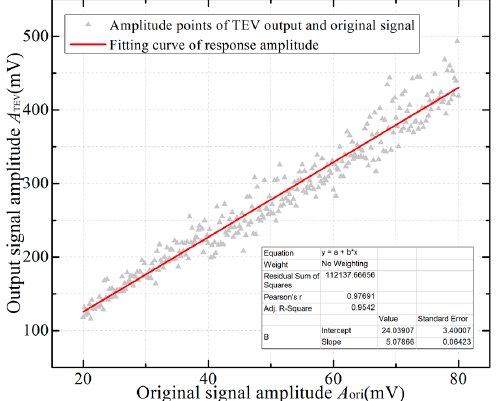
Figure 13. Amplitude calibration curve of wireless TEV sensor.